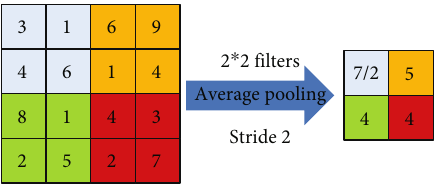
Figure 4: Average pooling